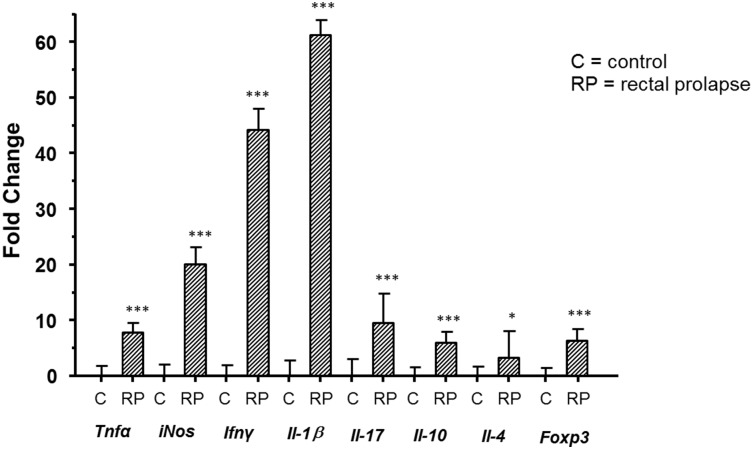
Lpd-/- mice with RP produced significantly higher mRNA levels of rectal inflammatory mediators compared healthy controls.Total RNA prepared from rectal tissues of mice were evaluated by qPCR for expression levels of mRNA for select cytokines, which then were normalized to the expression of the house-keeping gene Gapdh. The Y axis represents the mean fold change (± standard deviation) of the mRNA levels in reference healthy controls. P values: *** <0.0001, * <0.026.